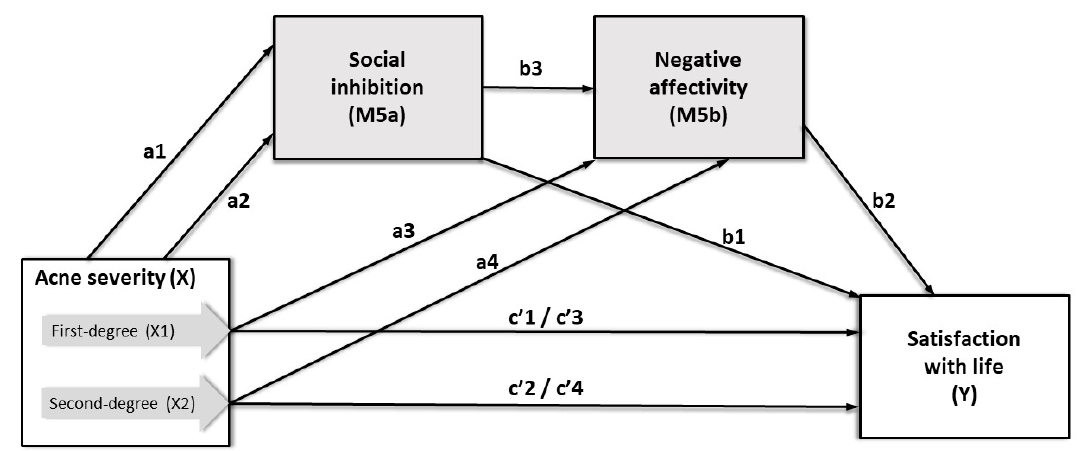
Figure 3. Serial multiple mediation model for predicting satisfaction with life (Study Model 5). Table 7. Path coefficients of acne severity (X1, X2), social inhibition (M5a), and negative affectivity (M5b) on satisfaction with life (Y) in a serial multiple mediation model. Antecedent Study Model 5a (M5a)